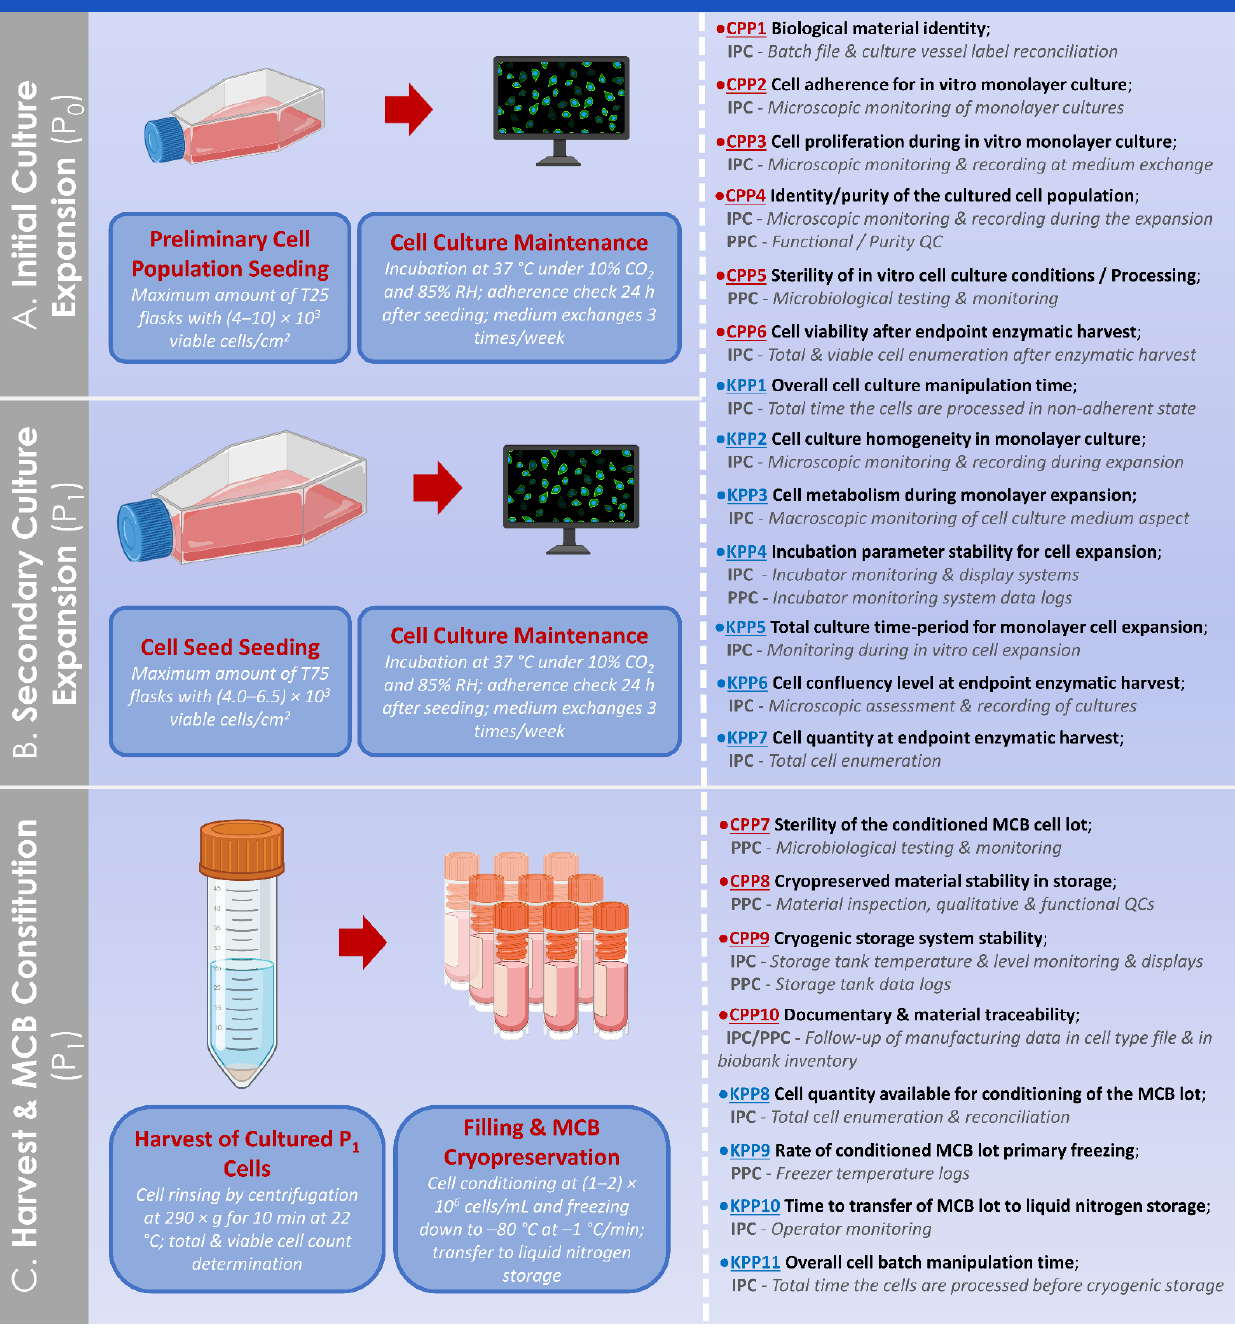
Figure 8. Standardized parametric and controlled process overview for the obtention of the MCB from the preliminary HAC cell population. ( A ) Initial in vitro culture expansion of the preliminary HAC cell population for the obtention of the cell seed. ( B ) Secondary in vitro culture expansion of the cell seed for the obtention of the cells used in MCB batch constitution. ( C ) Harvest and cryopreservation of the obtained cells for the establishment of the MCB. The established CPPs, KPPs, IPCs, and PPCs are further defined in the supplementary document–Process Parameters: Table SPP2. API, active pharmaceutical ingredient; CPP, critical process parameter; HAC, human articular chondrocytes; IPC, in-process control; KPP, key process parameter; MCB, master cell bank; PPC, post-process control; QC, quality control; RH, relative